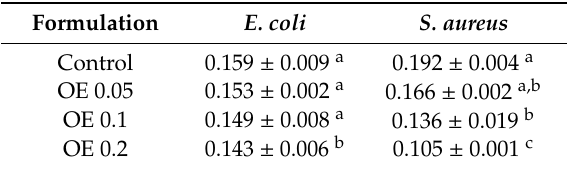
Table 5. Absorbance values obtained for antimicrobial activity (optical density method) of active edible films. Mean ± SD ( n =